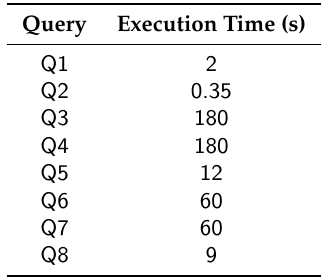
Table 1. Running